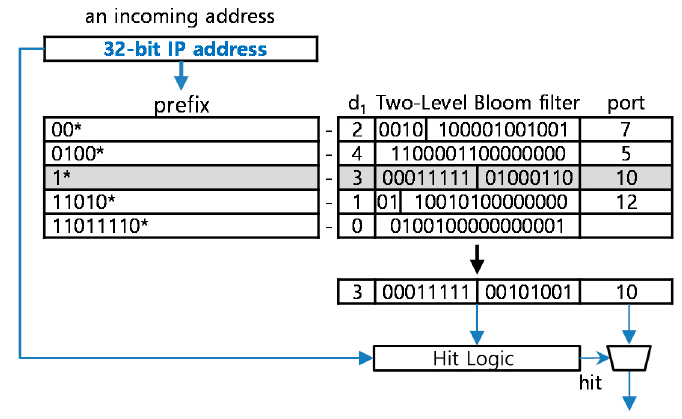
Figure 5. The structure of the two-level Bloom filter-based prefix cache (BFPC).